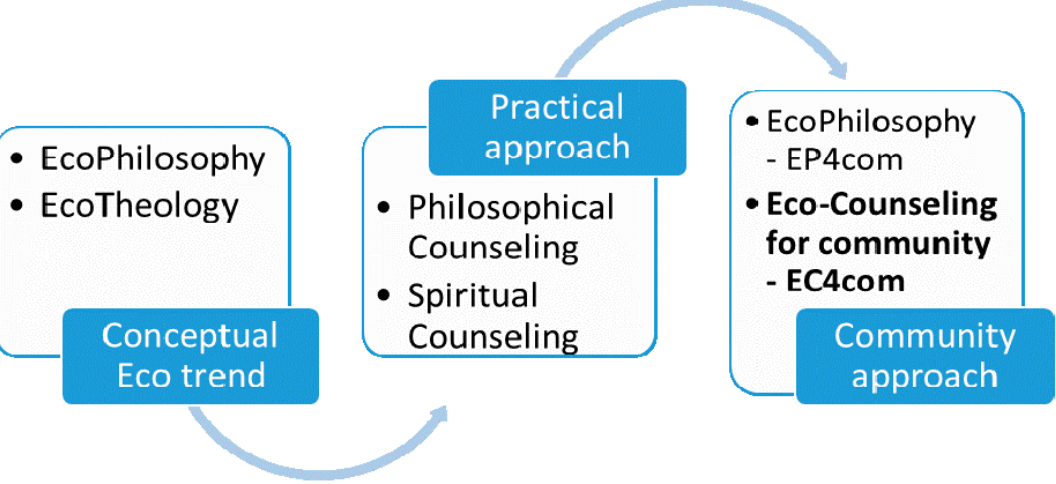
Figure 5. Eco-trend and practical counseling for communities.